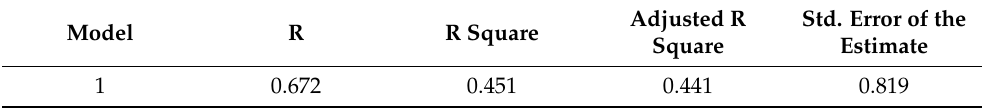
Table 11. Multilinear Regression results of female samples/Model Summary. Model R R Square